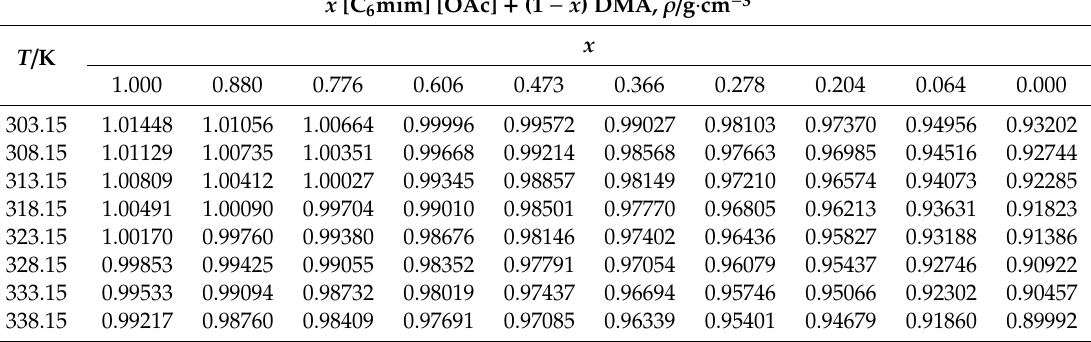
The relative standard uncertainty ( u r ) is u r ( ρ ) = 0.005. Table 4. Experimental densities of [C 6 mim] [OAc] with DMF at (0.0967 ± 0.002) MPa from 303.15 to 338.15 K and x is IL mole fraction.